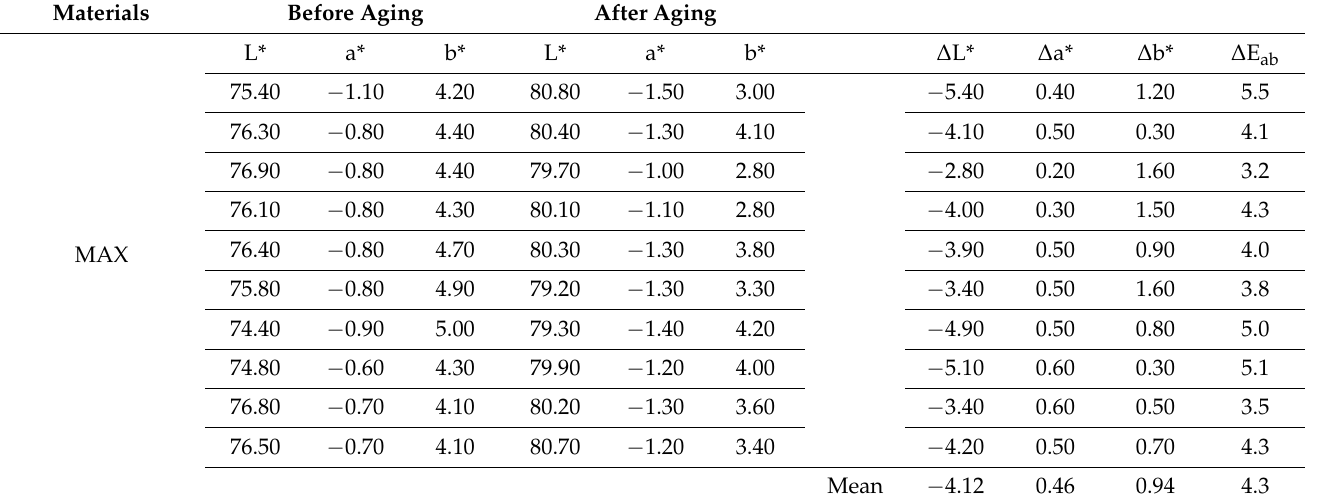
Table 3. Absolute values of the color parameters L*, a* and b* recorded before and after water aging, and calculated ∆ L*, ∆ a*, ∆ b*, ∆